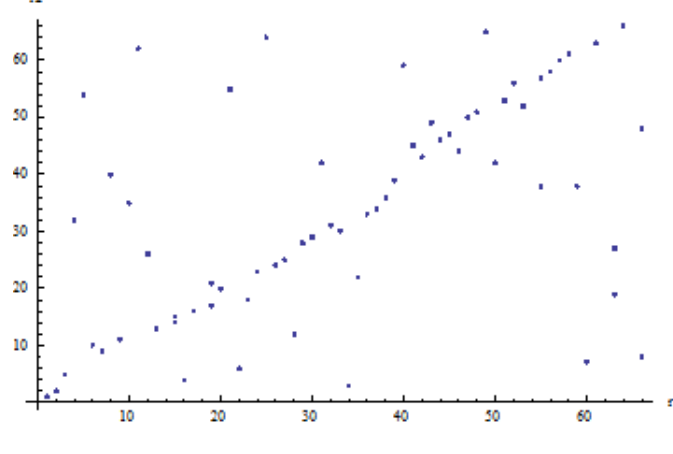
Figure 5. Ranks of the observations, old generation.